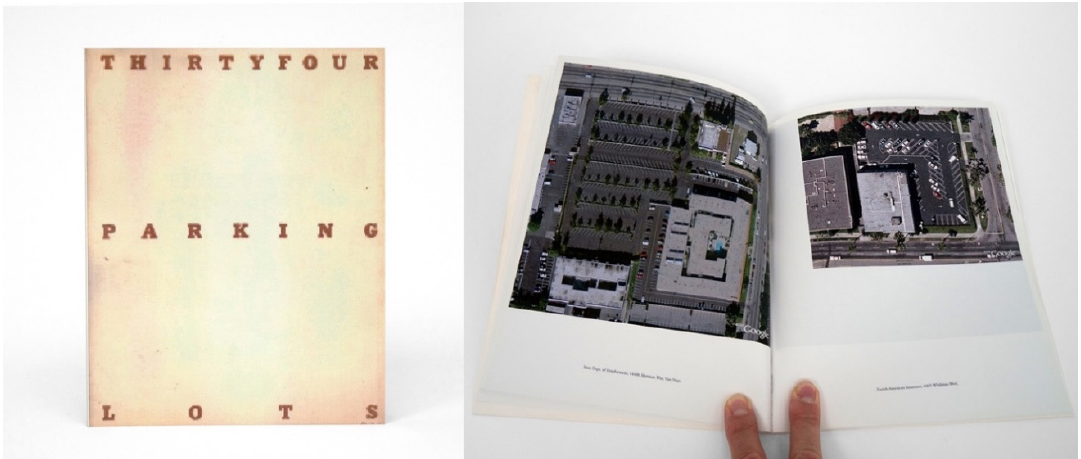
Arts 2019 , 8 , x FOR PEER REVIEW Figure 19. Hermann Zschiegner, Thirtyfour Parking Lots on Google Earth , 2006. Figure 19. Hermann Zschiegner, Thirtyfour Parking Lots on Google Earth , 2006.